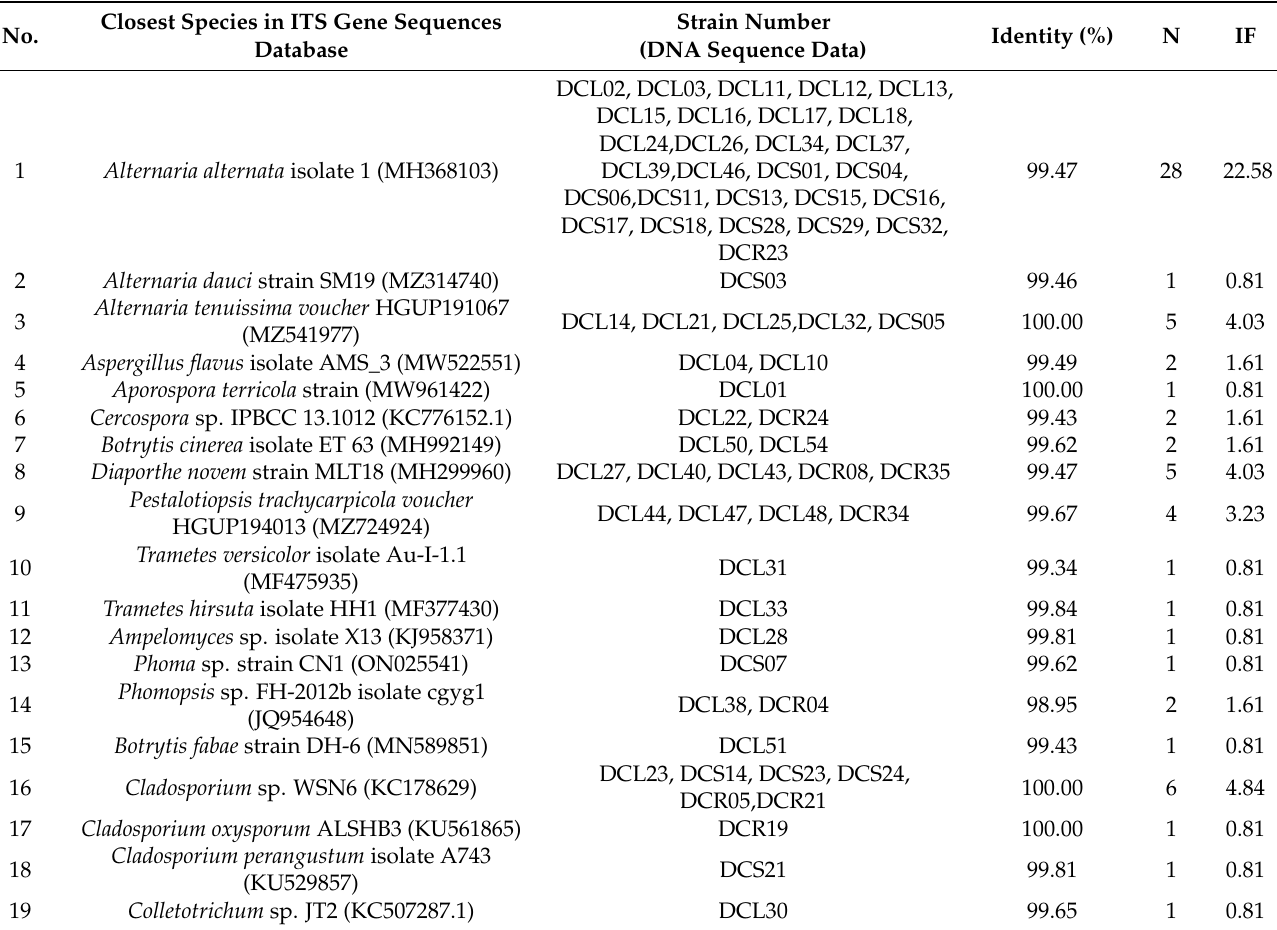
Table 1. Molecular identification of culturable endophytic fungi in A. adenophora based on GenBank database basic local alignment search tool